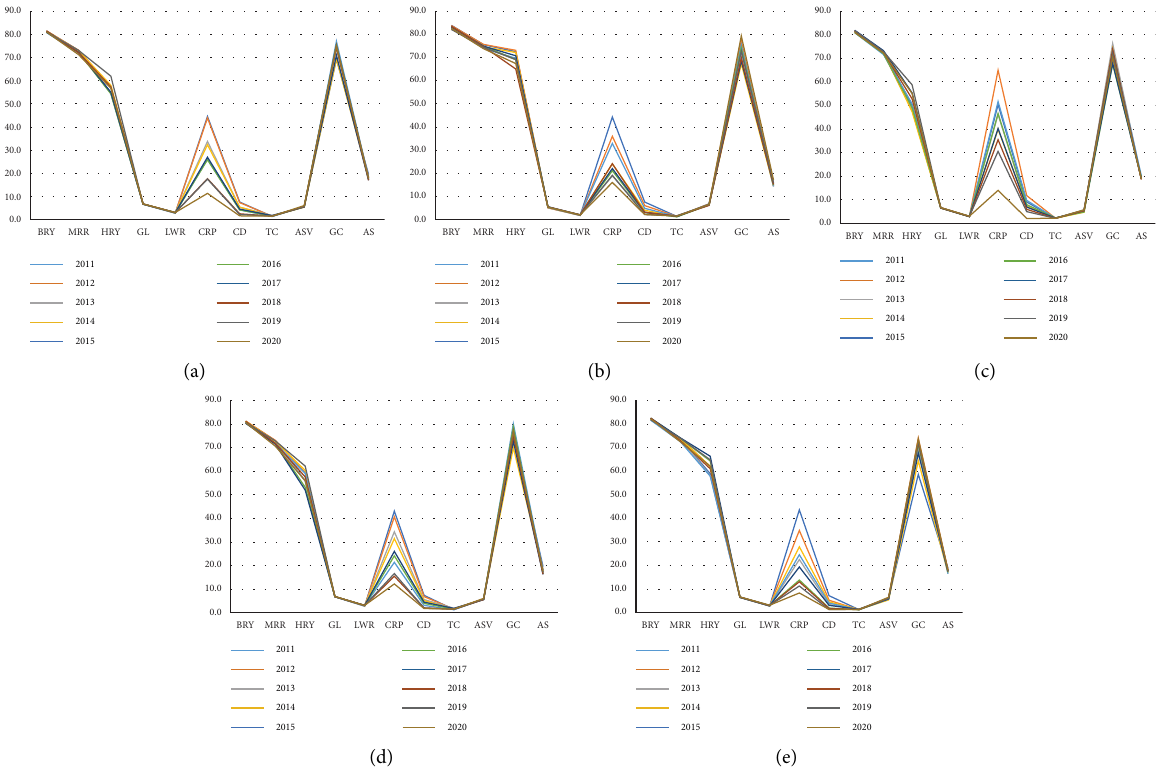
Figure 1: Rice quality indexes of indica rice (a), japonica rice (b), early rice (c), semilate rice (d), and late rice (e) in